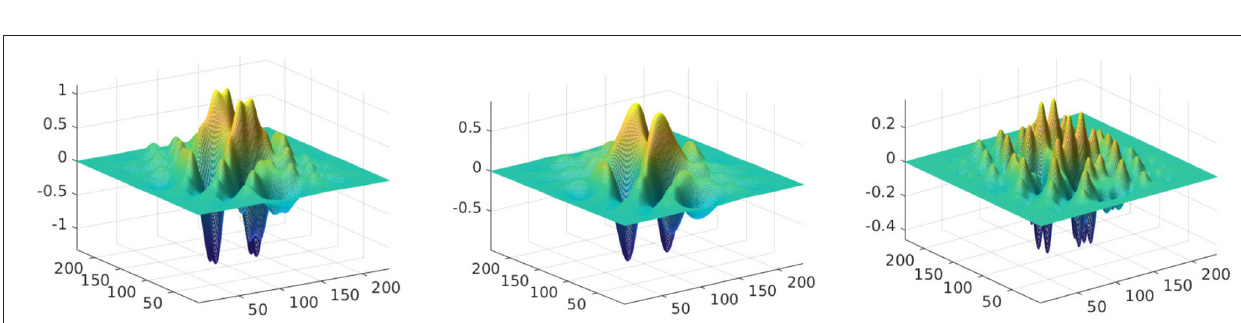
0.5 and with amplitudes modulated by the function Equation = 384, R 8, R l 3 and the number of nodes N = = =